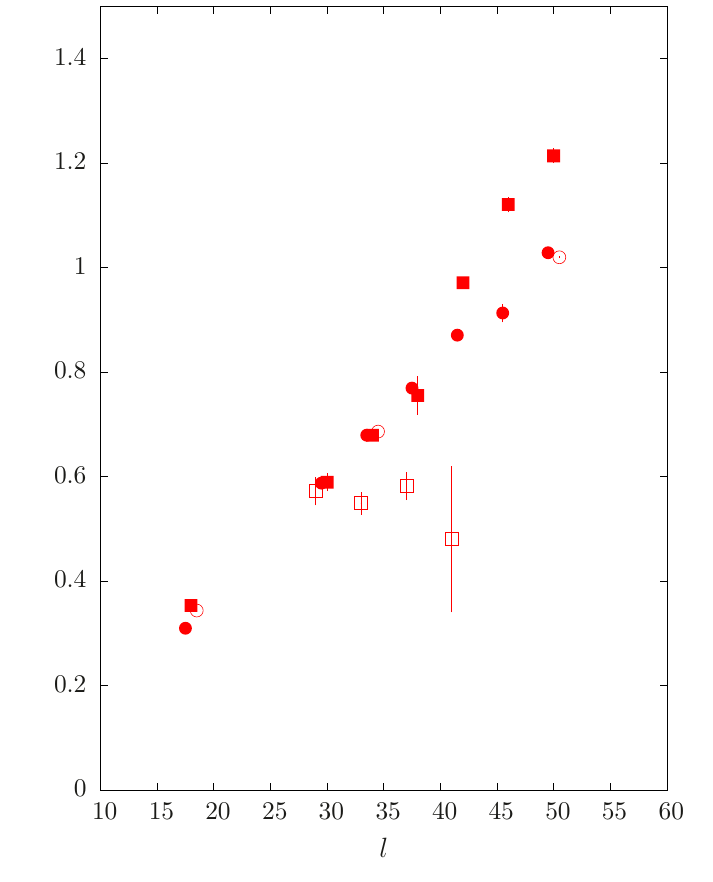
Figure 7 . Energy of lightest (cid:13)ux tube against its length: carrying fundamental ( (cid:12) = 13 : 87, and trace ( ) and Pfa(cid:14)an ( (cid:3) , (cid:4) ) in SO(4) at (cid:12) = 15 : 1. See text for di(cid:11)erence between (cid:15) the two Pfa(cid:14)an entries. Some points shifted slightly for